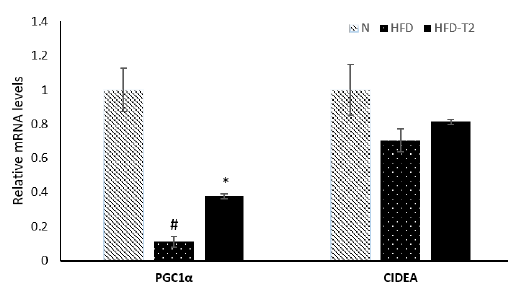
Figure 5. qPCR analysis of PGC1 α and CIDEA in sWAT of N, HFD, and HFD-T 2 rats. Values are means ± SEM of five independent experiments ( N = 5), # p < 0.05 vs. N; * p < 0.05 vs. N-HFD.